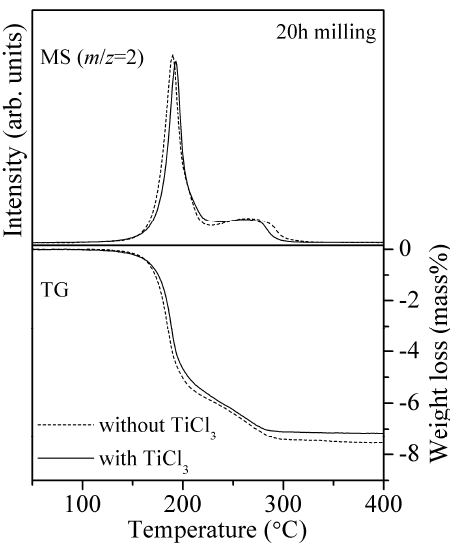
Figure 4. TG-MS profiles of the 8LiH-3Mg(NH 2 ) 2 samples with and without 0.54 mol% TiCl 3 synthesized by the ball-milling for 20